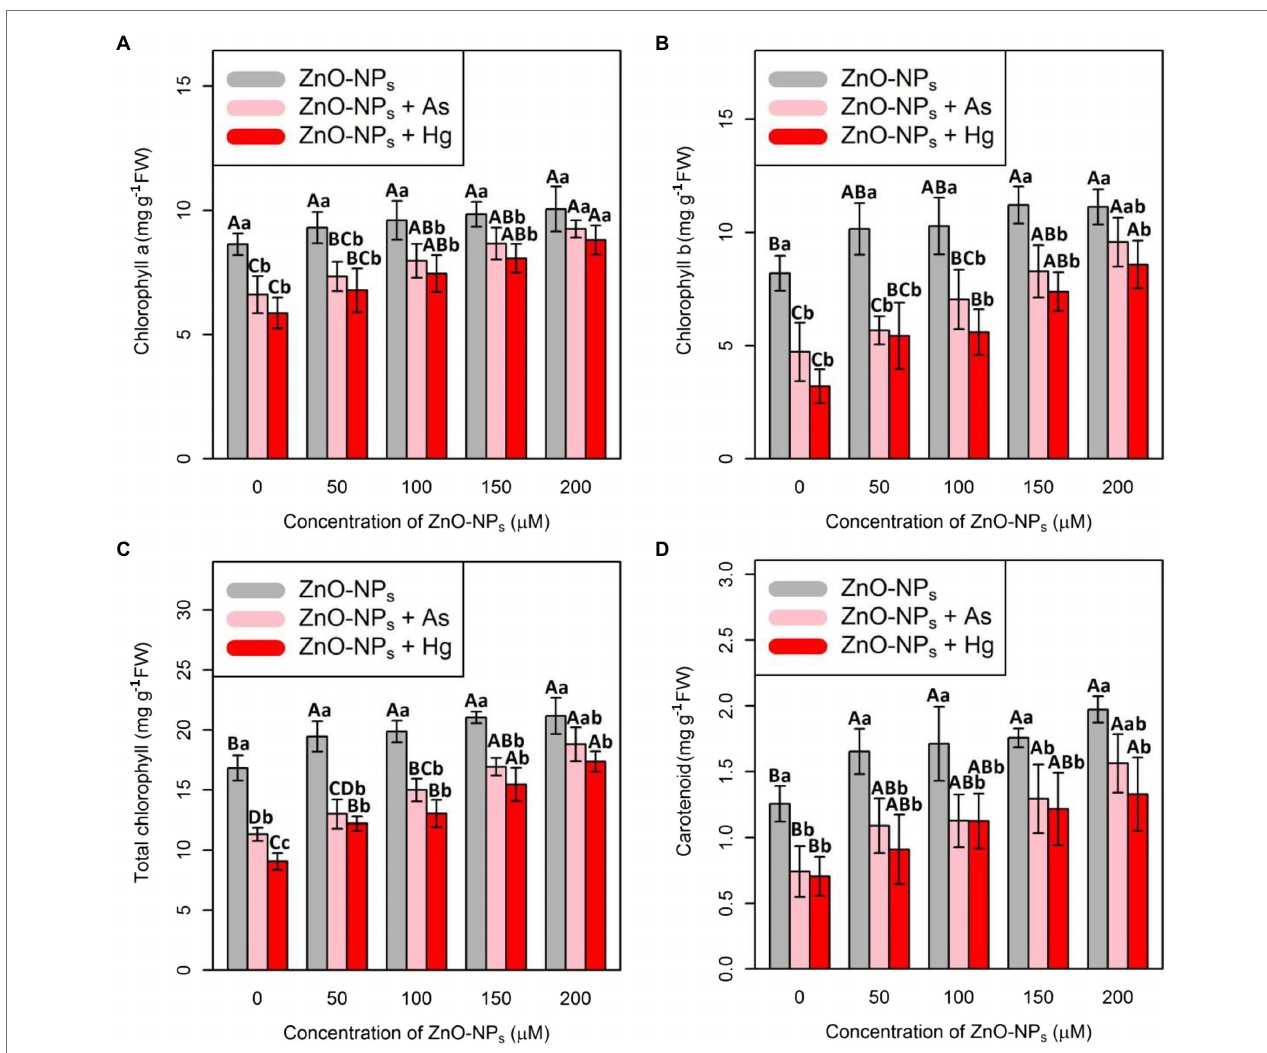
FIGURE 4 | Impact of the combination of ZnO-NPs with 150 μ M As and 150 μ M Hg on chlorophyll a (A) , chlorophyll b (B) , and total chlorophyll (C) as well as carotenoid contents (D) . Each data point is the mean ± SE of four replicates. The treatments included four levels of ZnO-NPs (50, 100, 150, and 200 μ M) alone and in combination with 150 μ M As and 150 μ M Hg. The capital letters indicated statistically significant differences across various levels of ZnO-NPs alone or in combination with 150 μ M As and 150 μ M Hg, while the lowercase letters displayed statistically significant differences within each level of ZnO-NPs alone and in combination with 150 μ M As and 150 μ M Hg based on Tukey’s test ( p < 0.05). They are superscripted on top of the